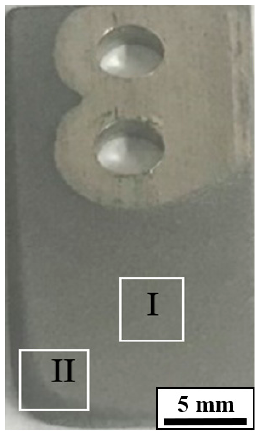
Figure 3. Macroscopic morphology of the worn specimen.